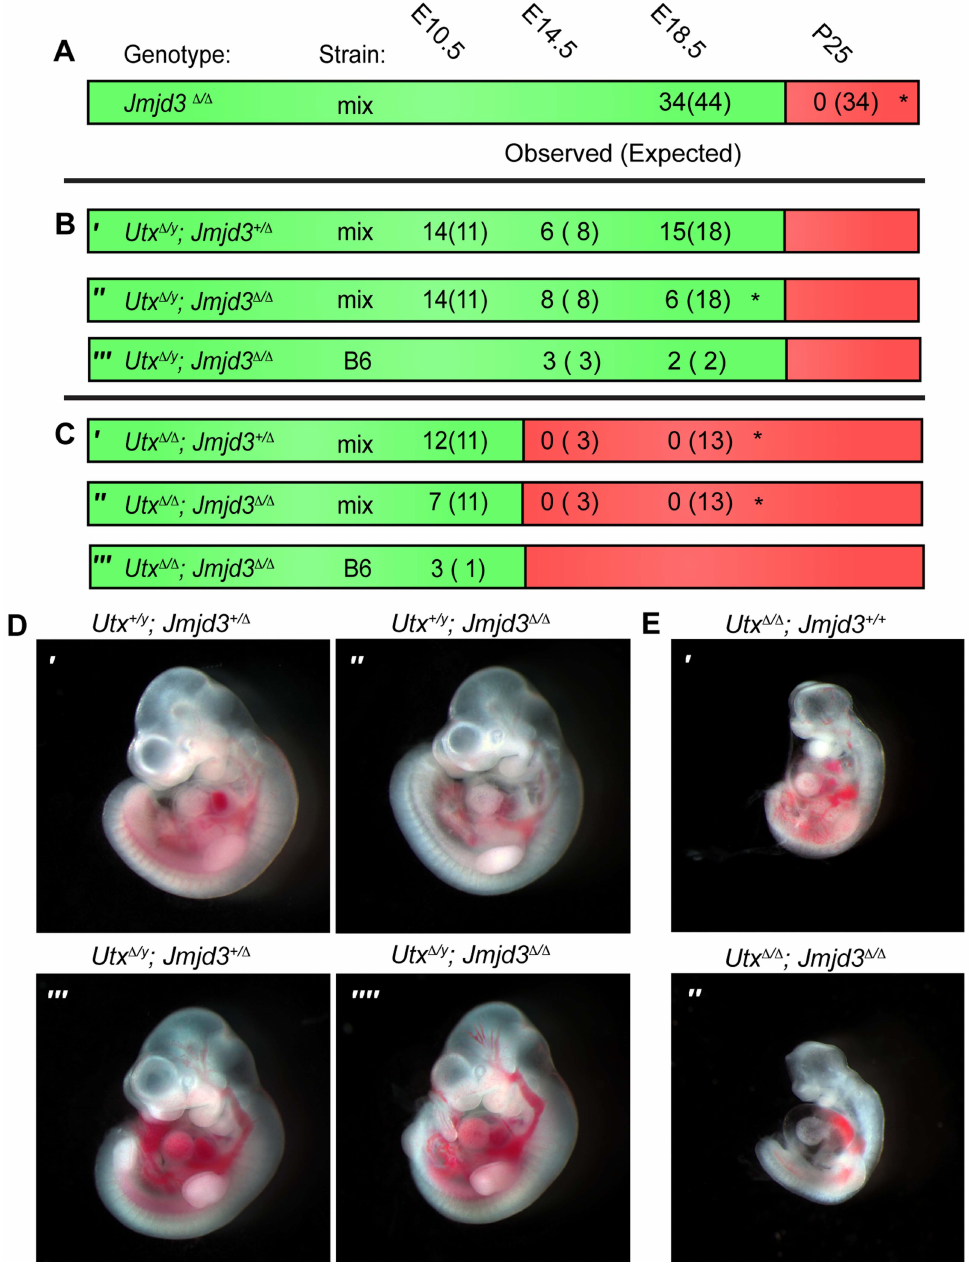
Figure 1. Utx and Jmjd3 mutant phenotypes. (A–C) Observed and Expected (in parentheses) numbers of indicated genotypes at embryonic (day 10.5, 14.5 or 18.5) or postnatal (day 25, weaning) timepoints. Data are included for Jmjd3 D / D (A), Utx D / y ; Jmjd3 + / D (B 9 ), Utx D / y ; Jmjd3 D / D (B 0 and B 90 ), Utx D / D ; Jmjd3 + / D (C 9 ), and Utx D / D ; Jmjd3 D / D (C 0 and C 90 ) genotypes. Green regions denote viability and red denotes lethality. Mix denotes a mixed genetic background and B6 has been backcrossed to C57BL6 for . 5 generations. Significant deviations from expected allele frequencies as determined by x 2 p-value are: (A) * , 0.001, (B) *=0.005, and (C) * , 0.001. (D,E) Embryonic day 10.5 images of (D) male Utx + /y ; Jmjd3 + / D (D 9 ), Utx + /y ; Jmjd3 D / D (D 0 ), Utx D / y ; Jmjd3 + / D (D 90 ), Utx D / y ; Jmjd3 D / D (D 00 ) embryos and (E) female Utx D / D (E 9 ) and Utx D / D ; Jmjd3 D / D (E 0 ) embryos, B6